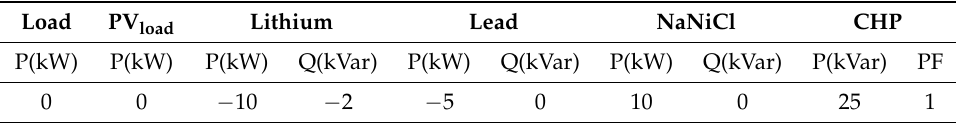
Table 3. Initial values set for Test